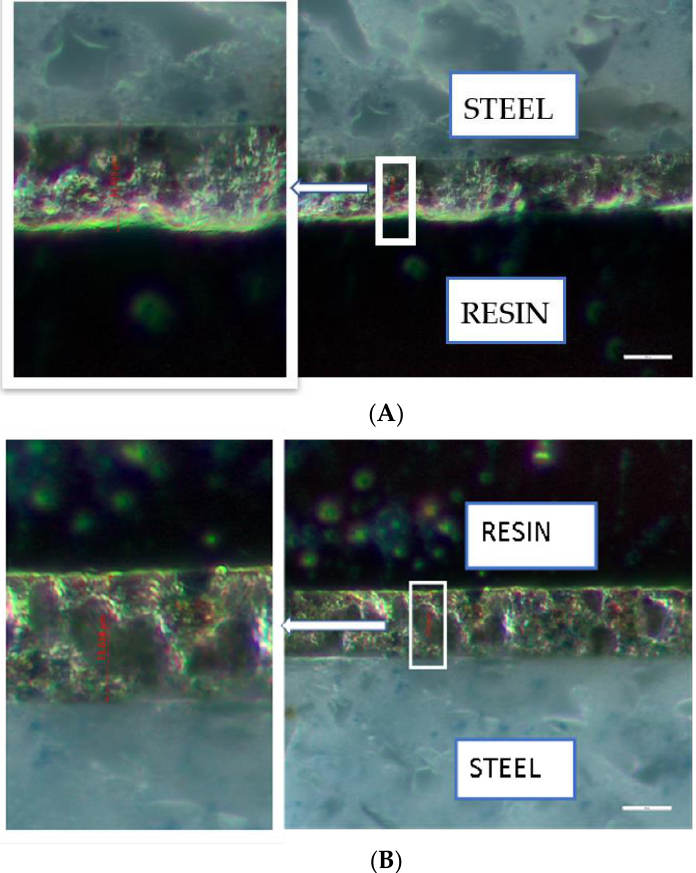
Figure 3. Cross-sections of hybrid ZnO/Zn ( A ) and CuO/Zn ( B ) hybrid coatings.